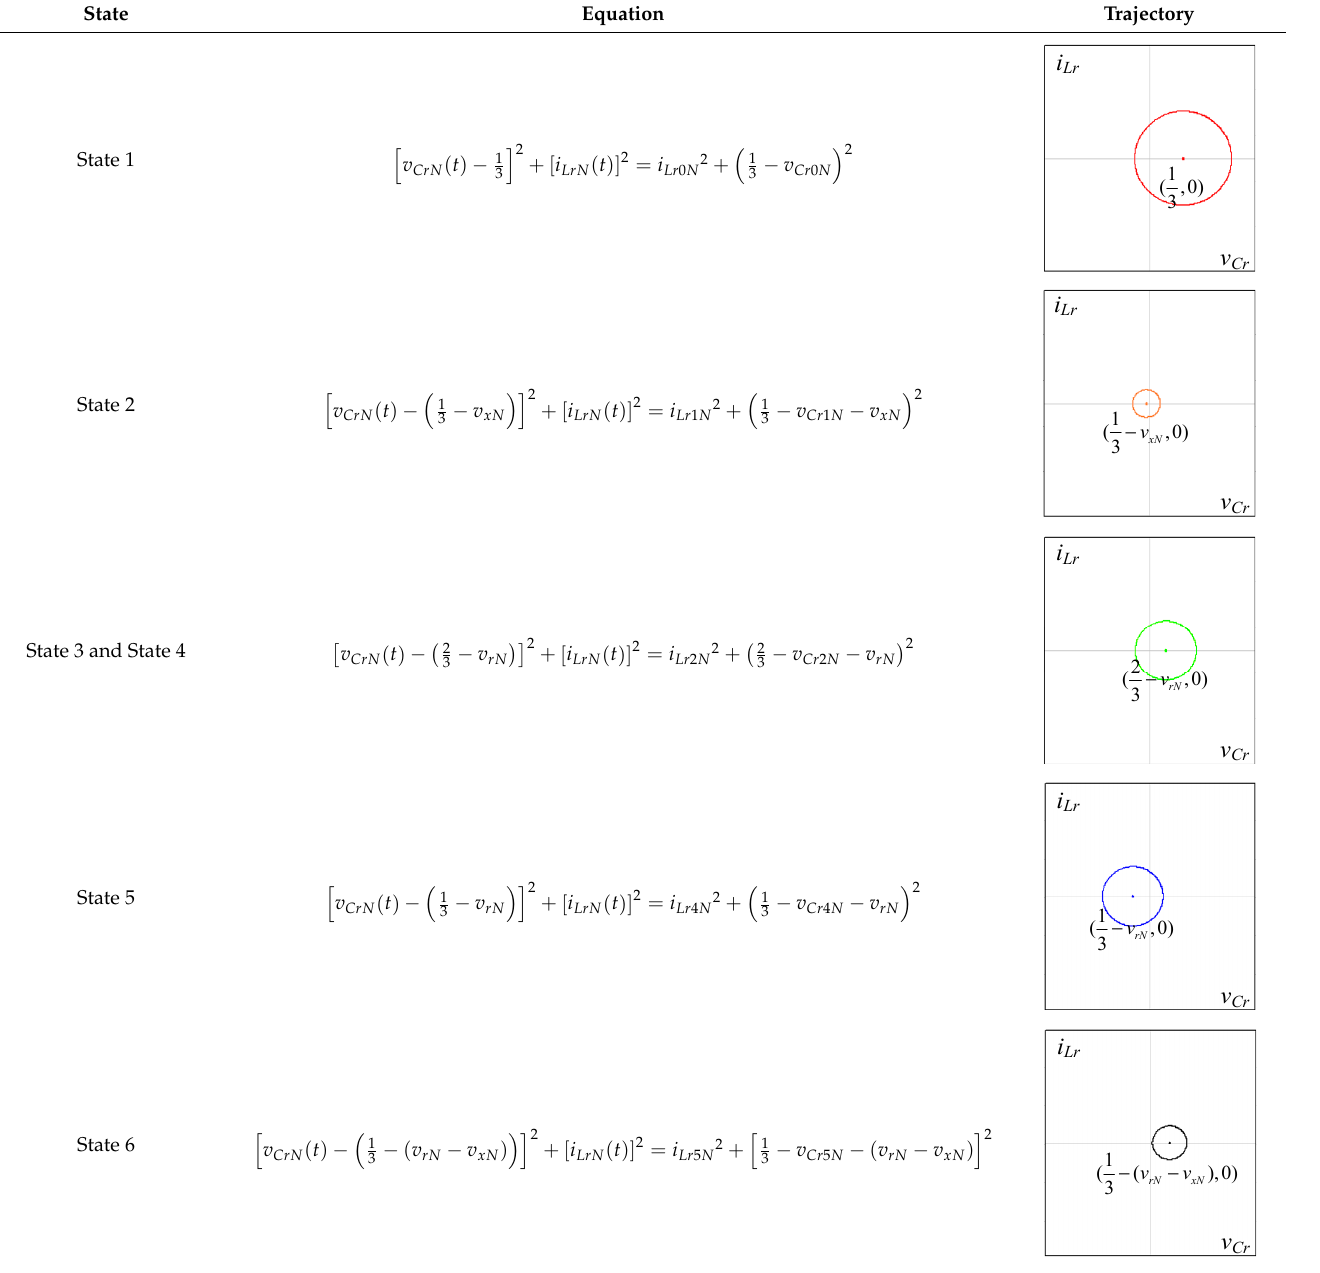
Figure 17. State–plane schematic diagram at 50% load. ( a ) normalizing form( b ) real value form. Table 3. Equations and state–plane trajectory.